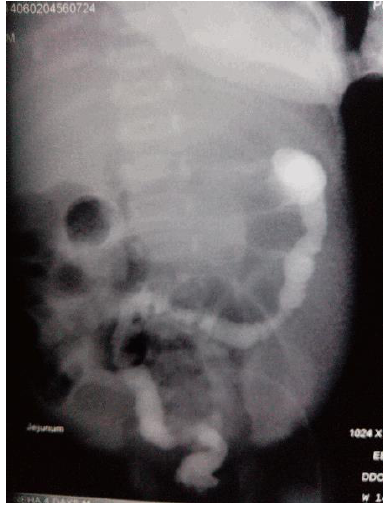
Figure 1: Contrast enema showing micro-colon. Three of the patients with ileostomy died in the immediate post-operative period due to